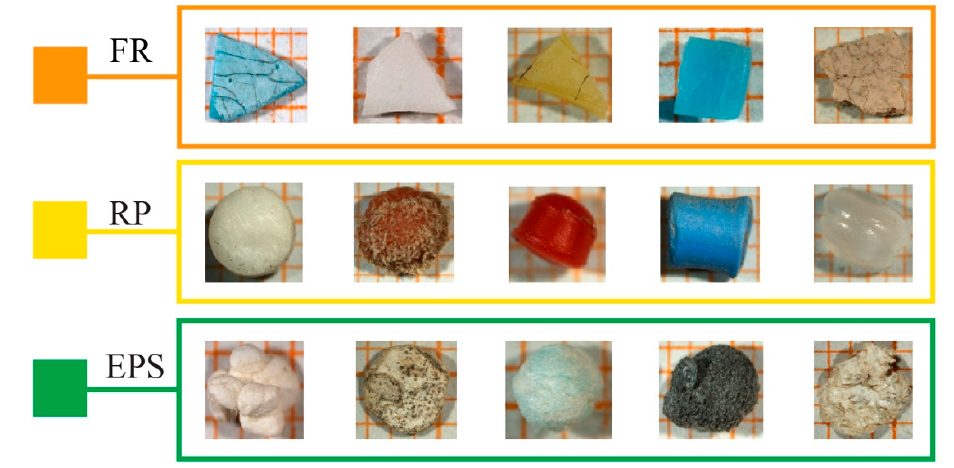
Figure 2. Physical appearance and color of some microplastics among those sampled, divided into = fragments, RP = resin pellets, EPS = expanded the three types considered. Legend: FR = fragments, RP = resin pellets, EPS = expanded polystyrene. three types considered. Legend: FR